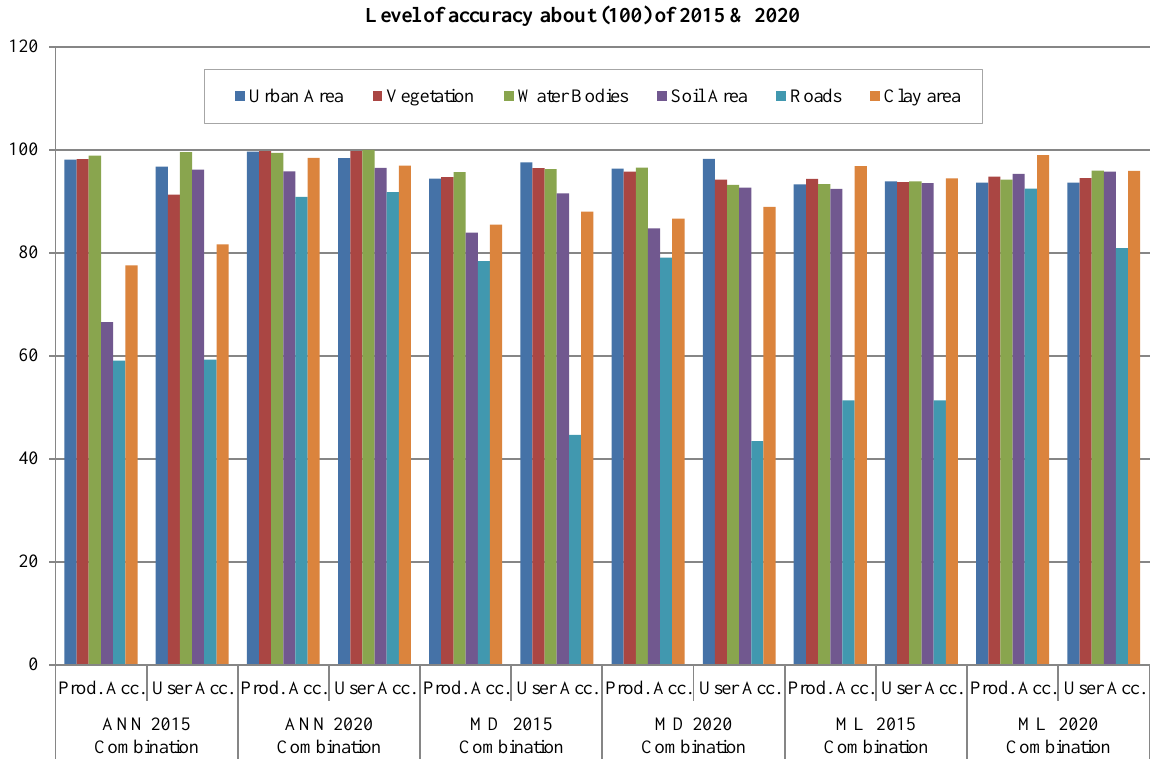
Figure 8. PA and UA of all classes of the integrated and classified thermal images of 2015 and 2020 by using classifiers: MD, ANN, and ML